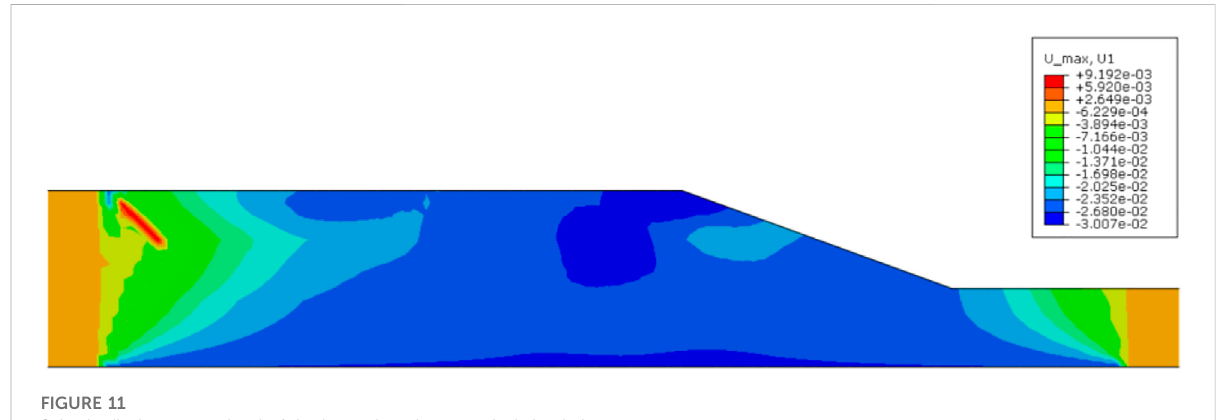
FIGURE 11 Seismic displacement cloud of the loess slope by numerical